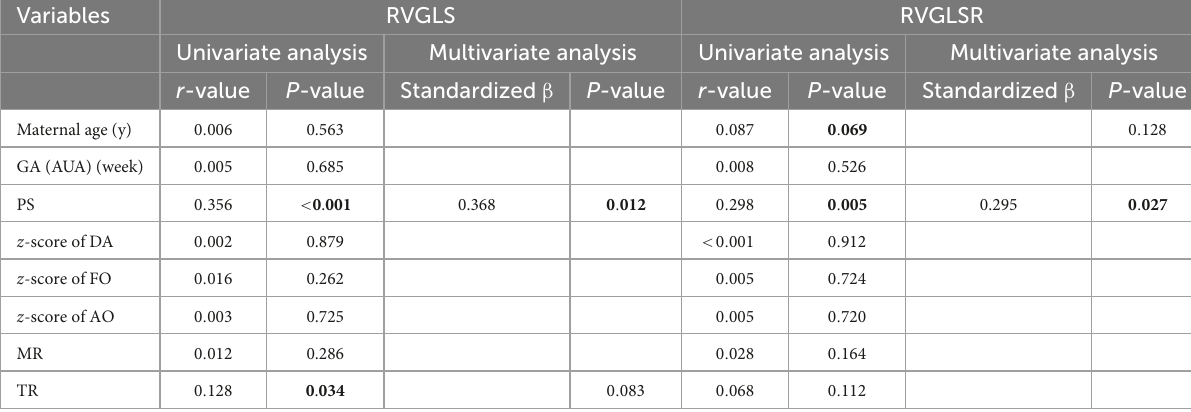
TABLE 6 Univariate and multivariate regression analyses for RVGLS and RVGLSR in the fetuses with TBA.